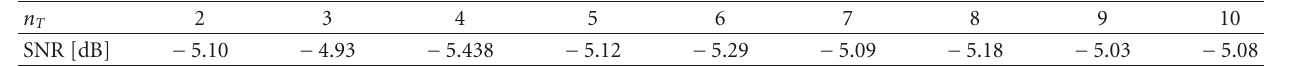
Table 1: Evaluation of (30) for K = 2 and rate R = 0 .